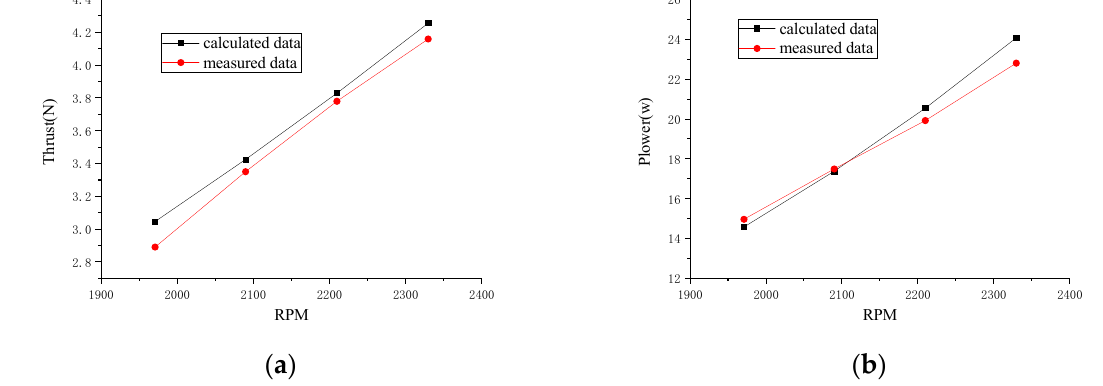
Figure 4. Comparisons of calculated data with measured data of hovering rotor. ( a ) Thrust distribution; ( b ) power consumption.